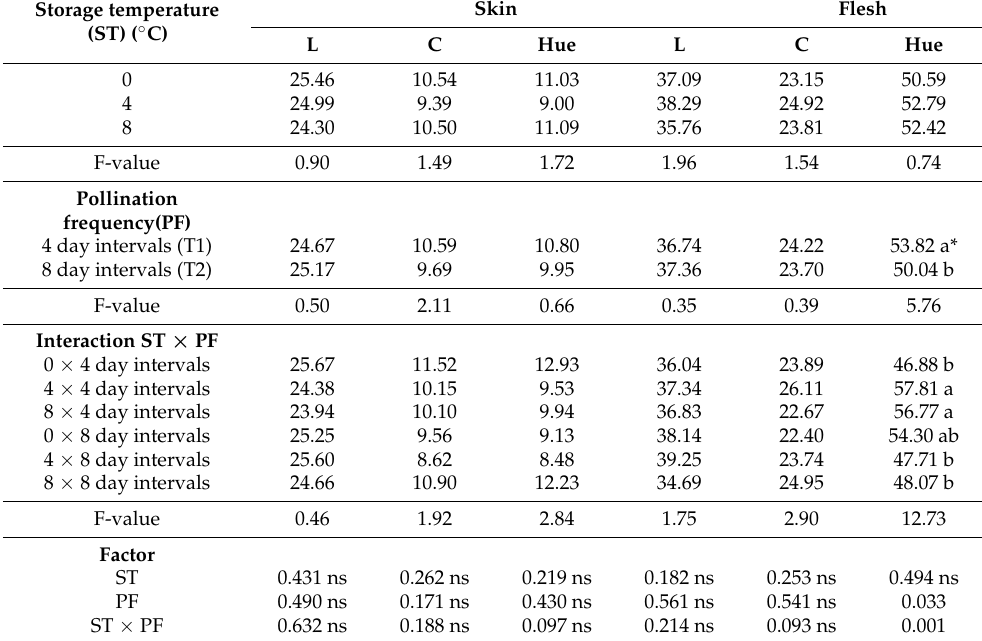
Table 4. The effect of storage temperature, pollination frequency, and their interaction on the skin and flesh color of the ‘Bursa Siyahı’ fig